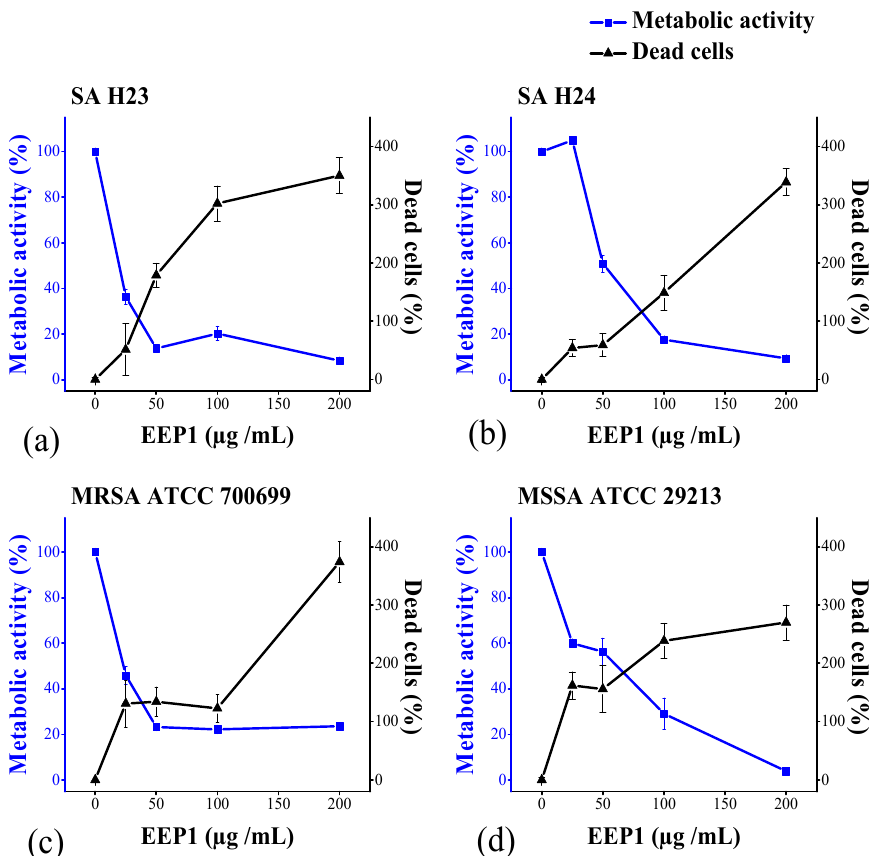
Figure 4. The effect of EEP1 (25–200 µ g/mL) on 24 h-old biofilms formed by: ( a ) Clinical isolates of S. aureus SA H23, ( b ) SA H24, ( c ) S. aureus ATCC 700699 (MRSA), and ( d ) S. aureus ATCC 29213 (MSSA), after 16 h incubation via the determination of metabolic activity of the cells that is in proportion to the resazurin fluorescent reaction (blue lines) and dead cells that is proportional to the fluorescence of propidium iodide (black lines) within the mature biofilms.